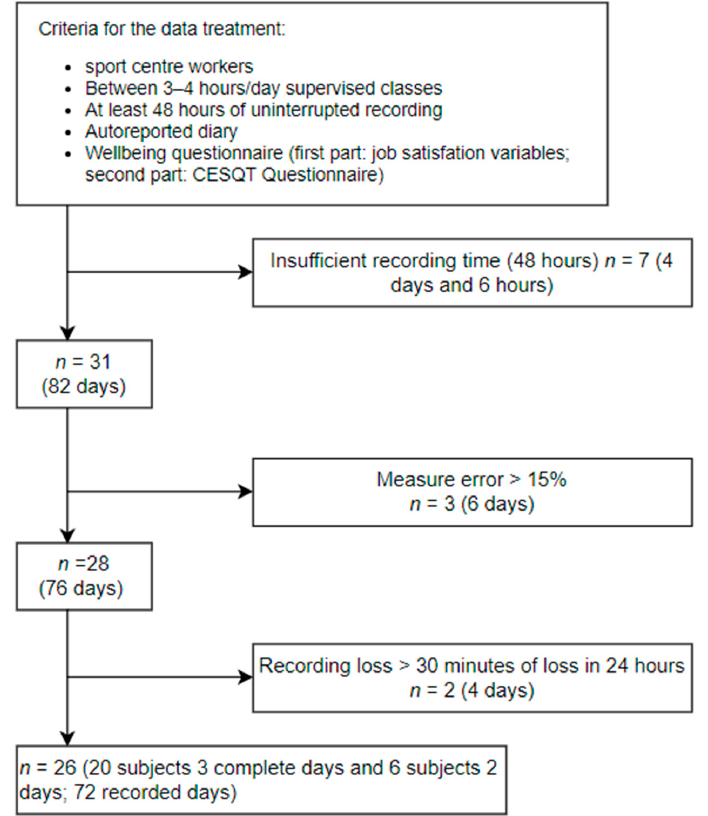
Figure 1. Flowchat describing the study design.